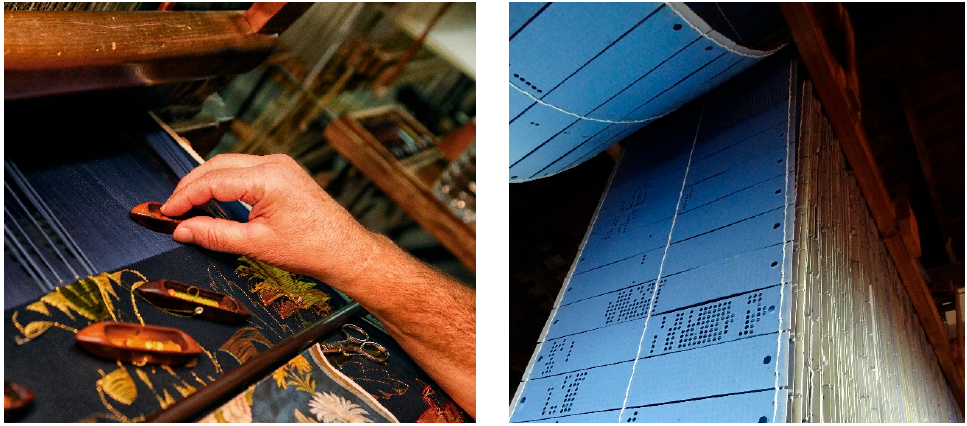
Figure 1. Jacquard looms: an artisan weaving a textile ( left ); punched cards that embed the textile’s drawing ( right ). Images belong to Garín 1820 S.A. [21].